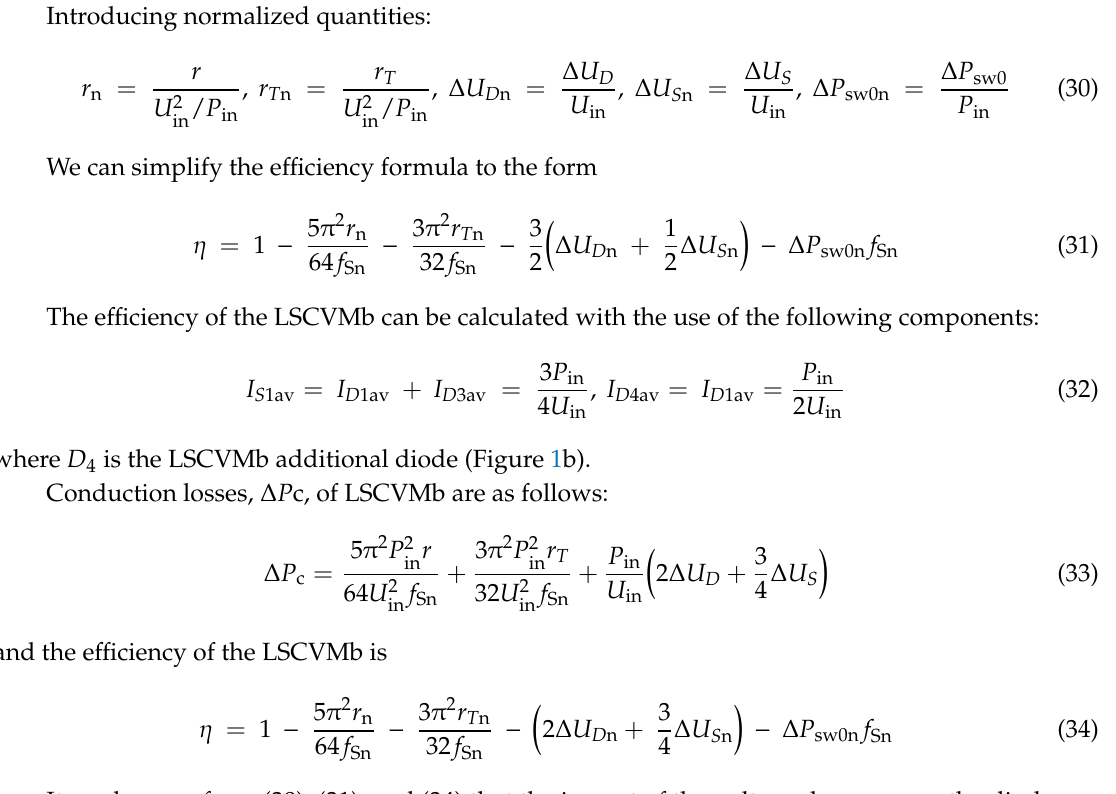
Figure 12. The value of r n = 0.0304 corresponds to, e.g., U in = 50 V, P in = 200 W, L = 500 nH, C = 1.5 μ F, r = 380 m Ω , and Δ U D n is equal to 0.008 for, e.g., Δ U D = 0.40 V and U in = 50 V. The value of relative